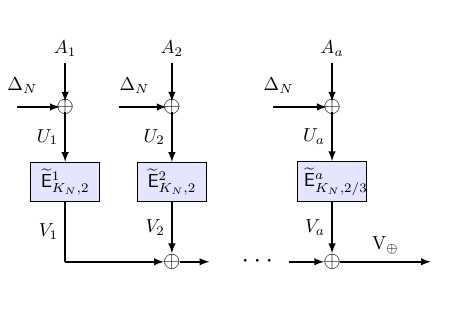
Figure 1: Associated Data Processing for both LOCUS and LOTUS . Here e E i invocation of e E with key α i (cid:12) K N and tweak 0010. For the final associated data